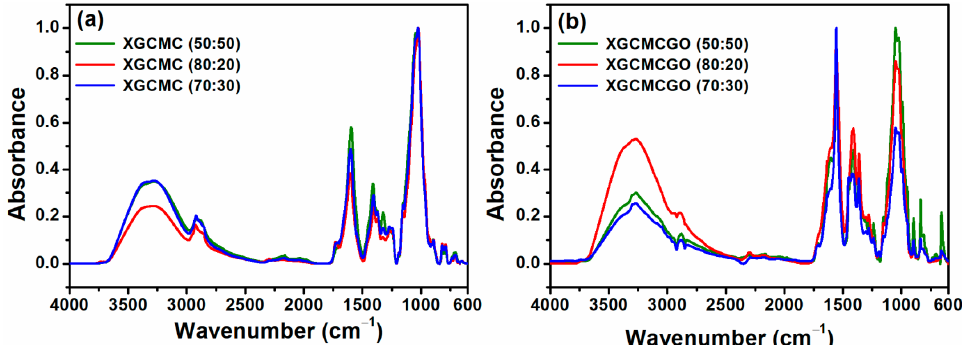
Figure 5. ( a ) The FTIR spectra of XGCMC without GO dried hydrogel; ( b ) the FTIR spectra of XGCMCGO dried